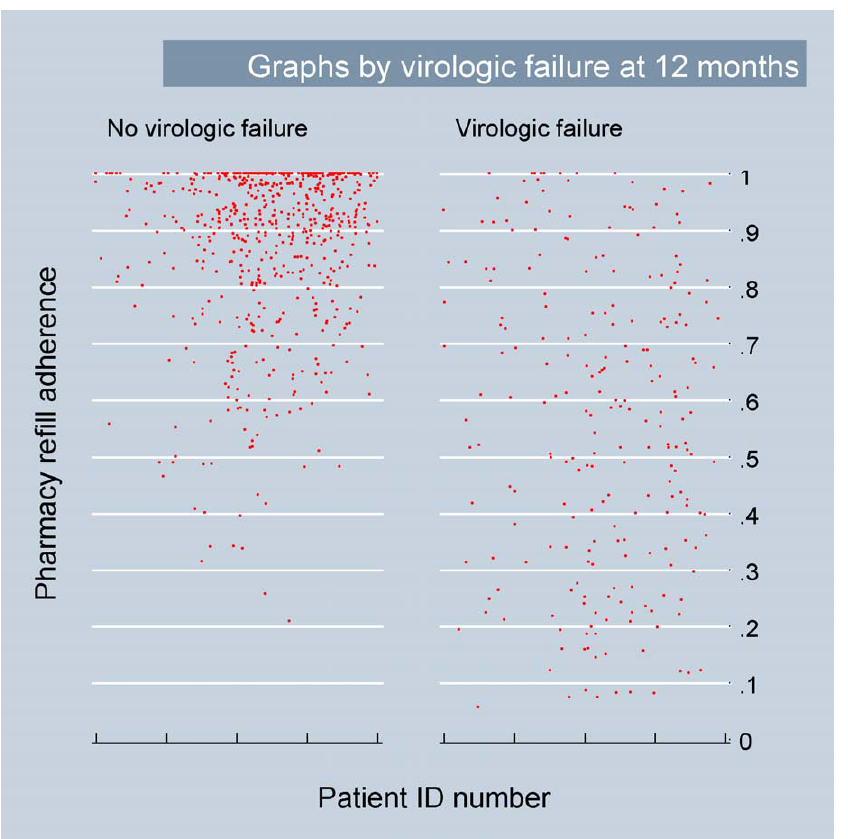
Figure 4. Scatter Plot of Pharmacy Refill Adherence Levels at 12 Months after Starting cART for Patients with and without Virologic